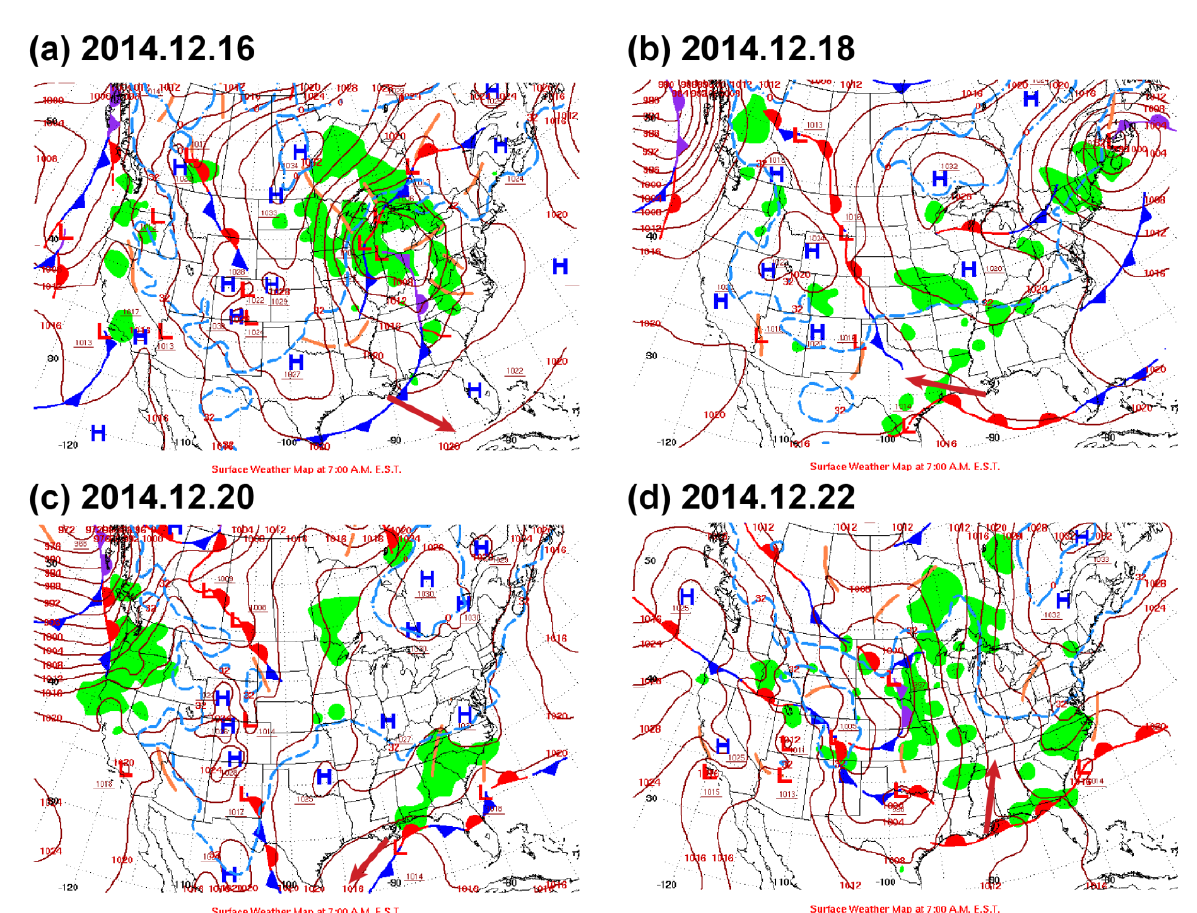
Figure 3. Daily surface weather maps at sea level around the survey time in December 2014 (downloaded from [35]). The red lines with numbers in figure are isobars; H and L indicate central areas of high pressure and low pressure, respectively; blue lines with triangles indicate the locations of cold fronts; red lines with semicircles indicate warm fronts; lines with alternate symbols on other sides are stationary fronts; purple lines with triangles and semicircles on the same side represent occlusions; green shading areas indicate precipitation regions; the red arrow stemming from our study area on each panel indicates the local wind direction at the study site. ( a – d ) Studies on the 16, 18, 20, and 22 December in the year 2014.